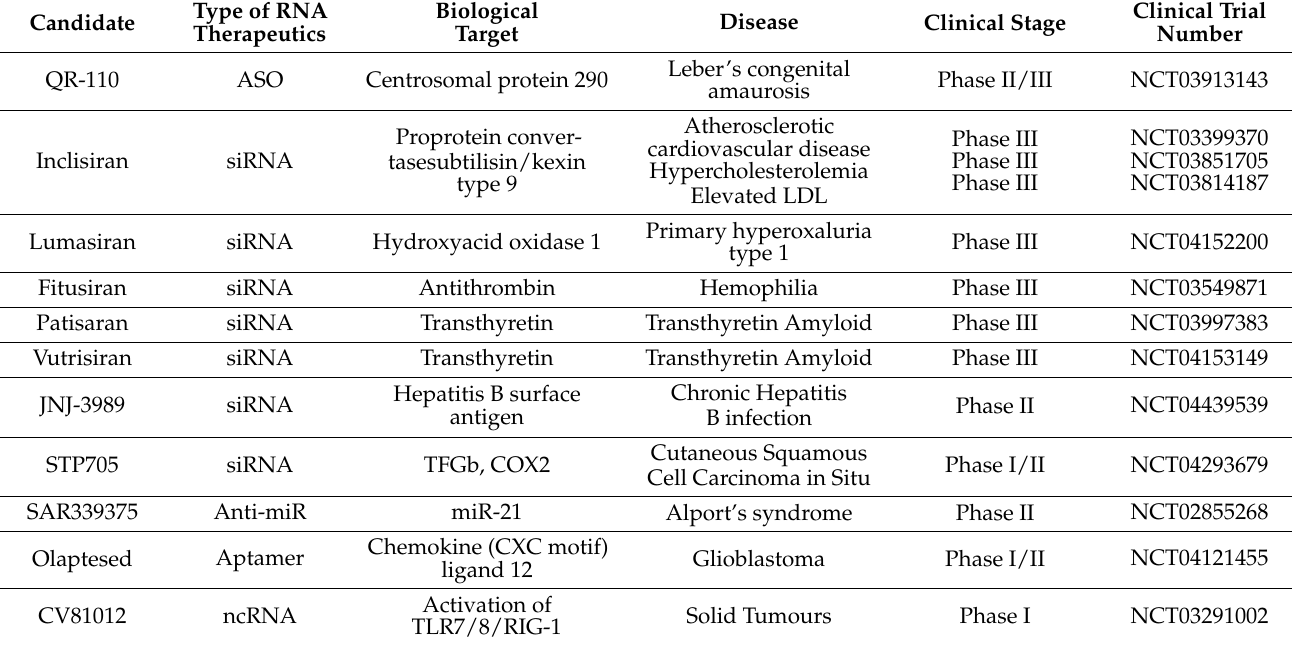
Table 4. RNA therapeutics in clinical trials. Phase III trials are presented in all diseases, along with all phase trials in cancer.